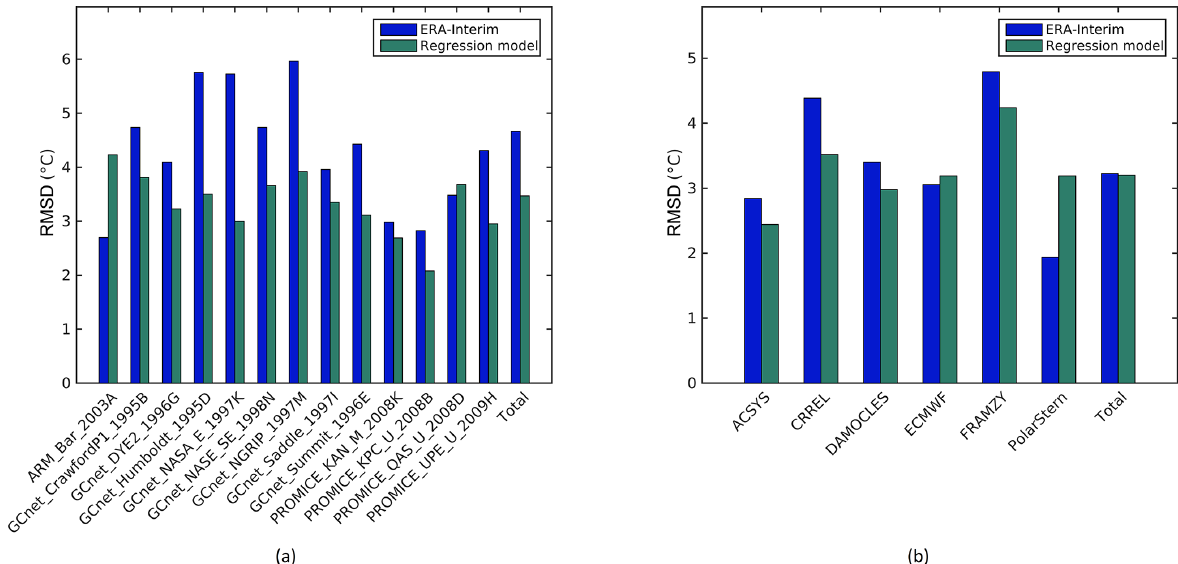
Figure 12. Root-mean-square differences (RMSDs) calculated for the (a) land ice sites and (b) sea ice sites using T2m from ERA-Interim, ERA5, and the regression model, respectively. Only buoys with more than 200 observations are included. The last two bars listed as “total” are the RMSD obtained by using all validation